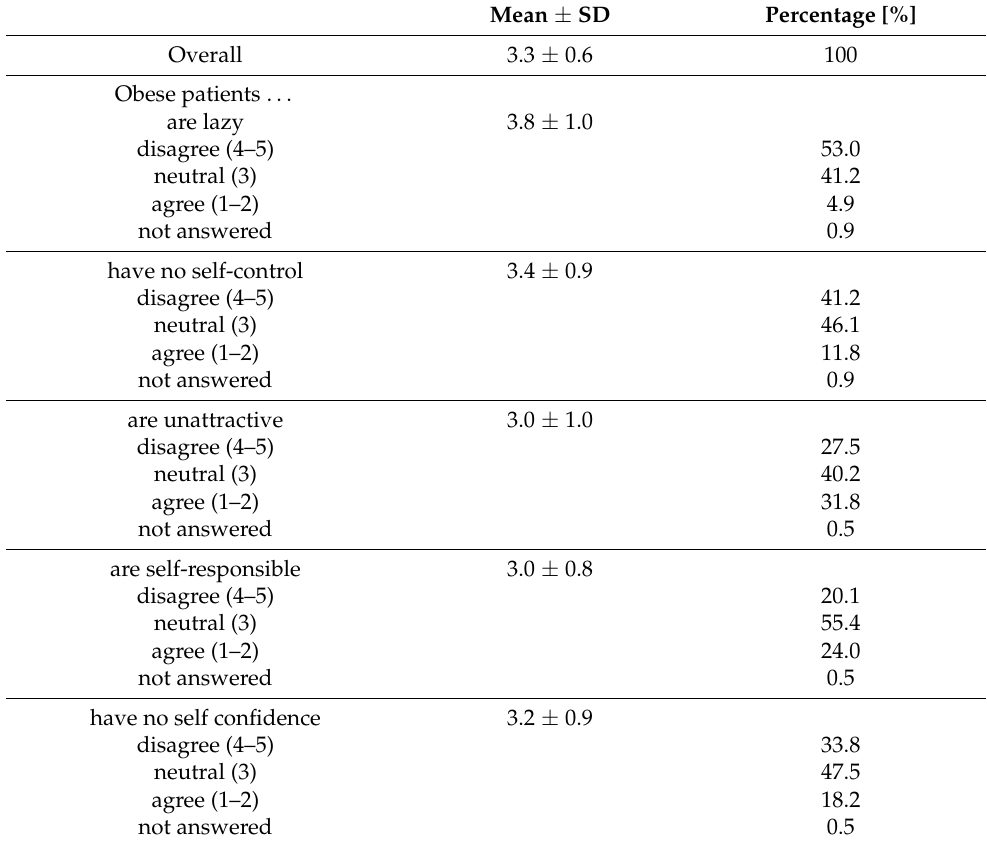
Table 3. Stereotypes and